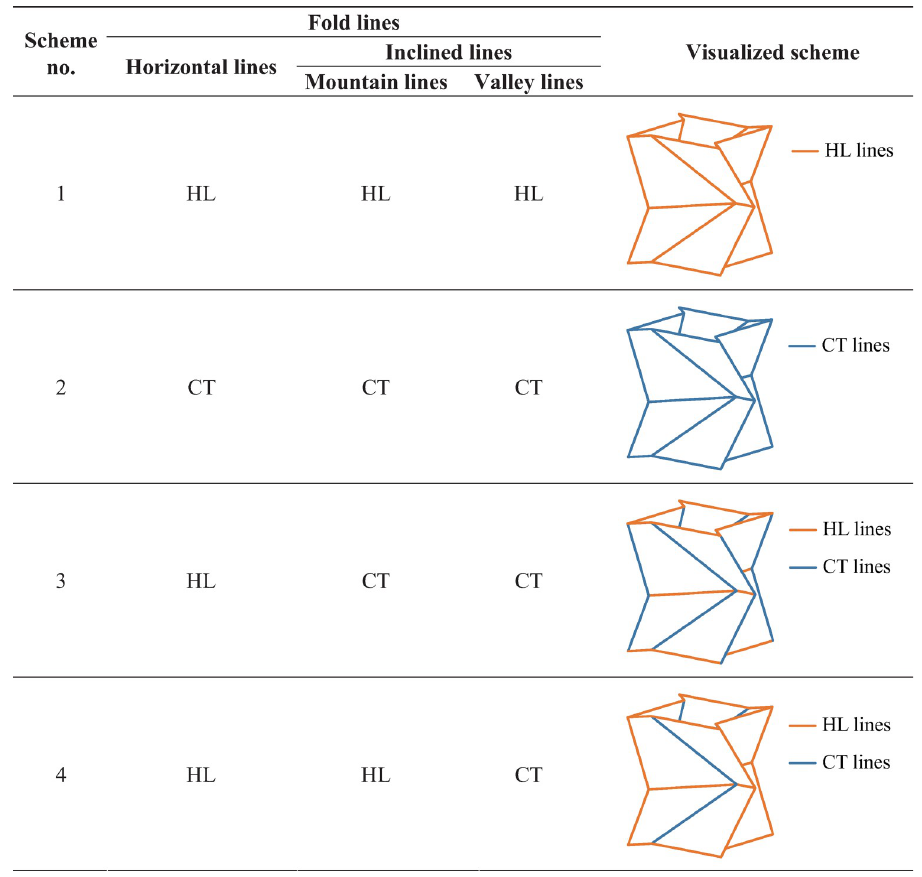
Fig 3. Schemes of fold